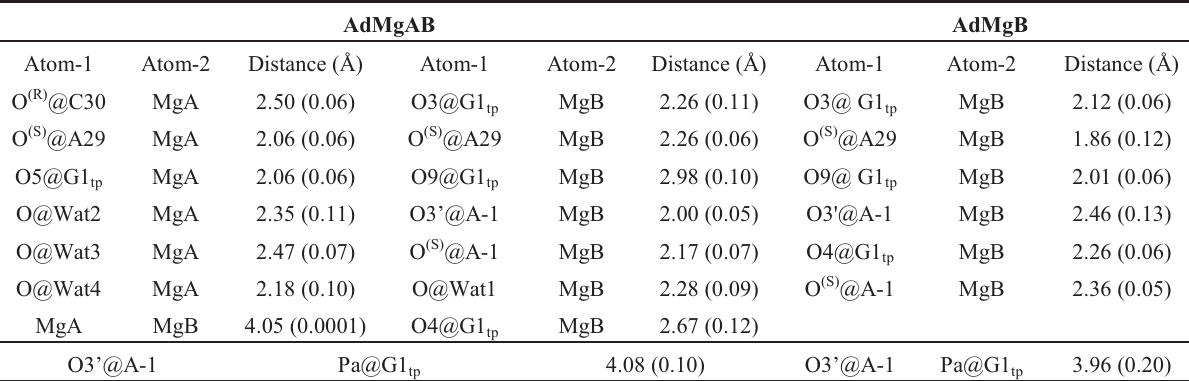
Table 2. Average bond lengths (Å) of Mg(II) ions and the coordination ligands obtained from the QM/MM MD of the AdMgAB and AdMgB. Standard deviations are reported in parenthesis.